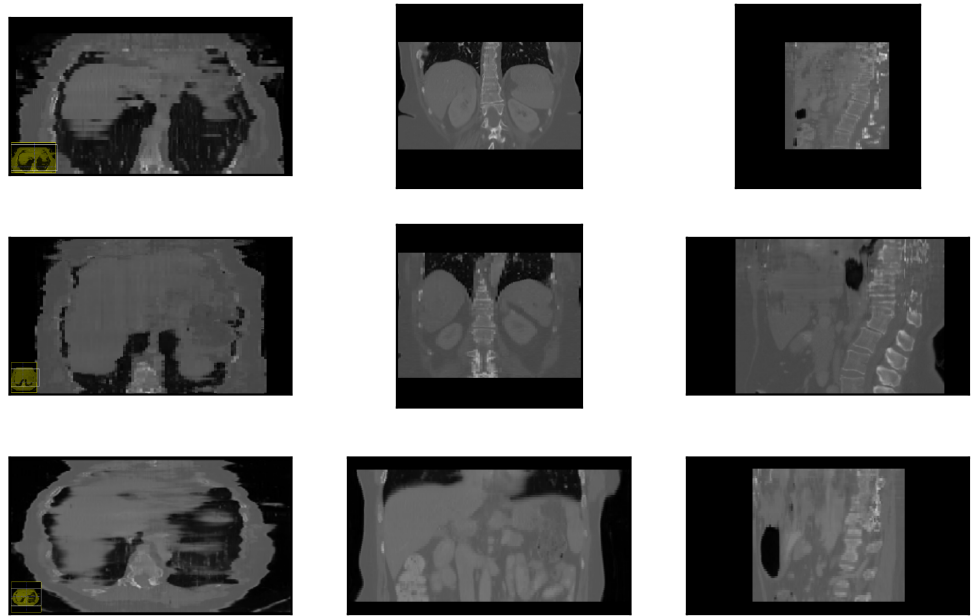
Figure A1. 2D extrapolation examples. Left —axial view; Middle —coronal frame (extrapolation axis); Right —sagittal